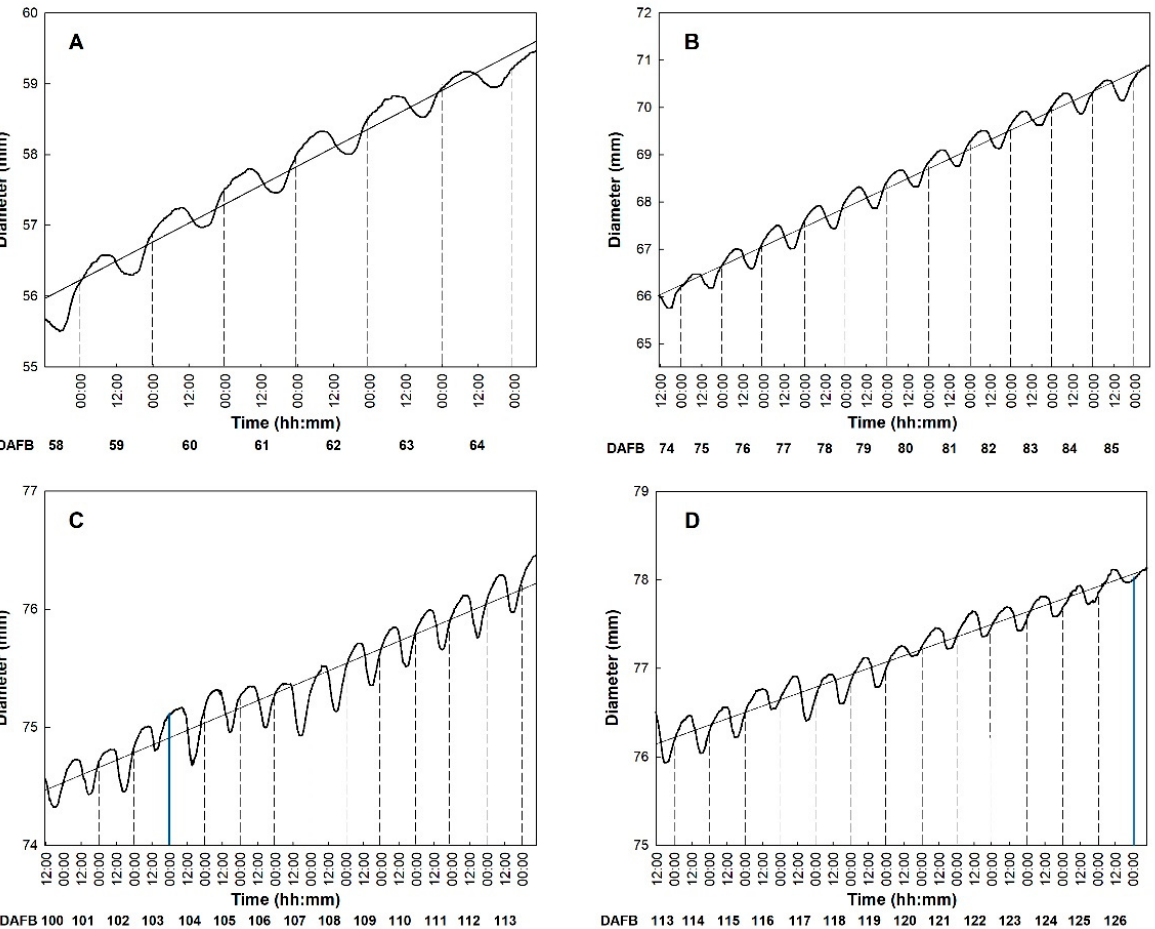
Figure 3. Trends of diametric growth of ‘Keitt’ mangos in the four observation periods monitored by fruit gauges every 15 min from 58 to 64 DAFB ( A ), from 74 to 85 DAFB ( B ), from 100 to 113 days DAFB ( C ), and from 114 to 126 DAFB ( D ). The blue lines indicate days of rainfall. Period I: Diameter = 0.535DAFB − 23,297; R 2 = 0.957; p < 0.001. Period ( II ): Diameter = 0.410DAFB – 17,864; R 2 = 0.978; p < 0.0001. Period ( III ): Diameter = 0.126DAFB − 5434; R 2 = 0.910; p < 0.001. Period ( III ): Diameter = 0.142DAFB − 6137; R 2 = 0.948; p < 0.001.